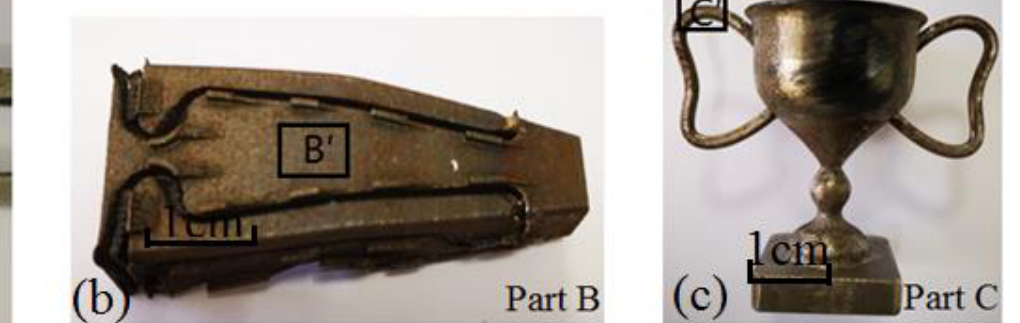
Figure 6. Three samples of high-intensity MS laser additive manufacturing. ( a ) High-strength steel additive manufacturing plane in Part A, ( b ) high-strength steel additive manufacturing small amplitude curved in Part B, and ( c ) three-dimensional sample with large curvature in Part C.